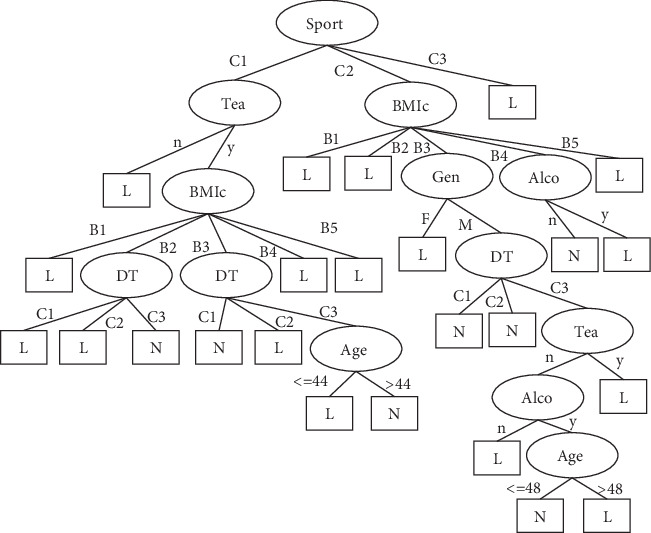
Decision tree #4 to classify risk factors of stroke.